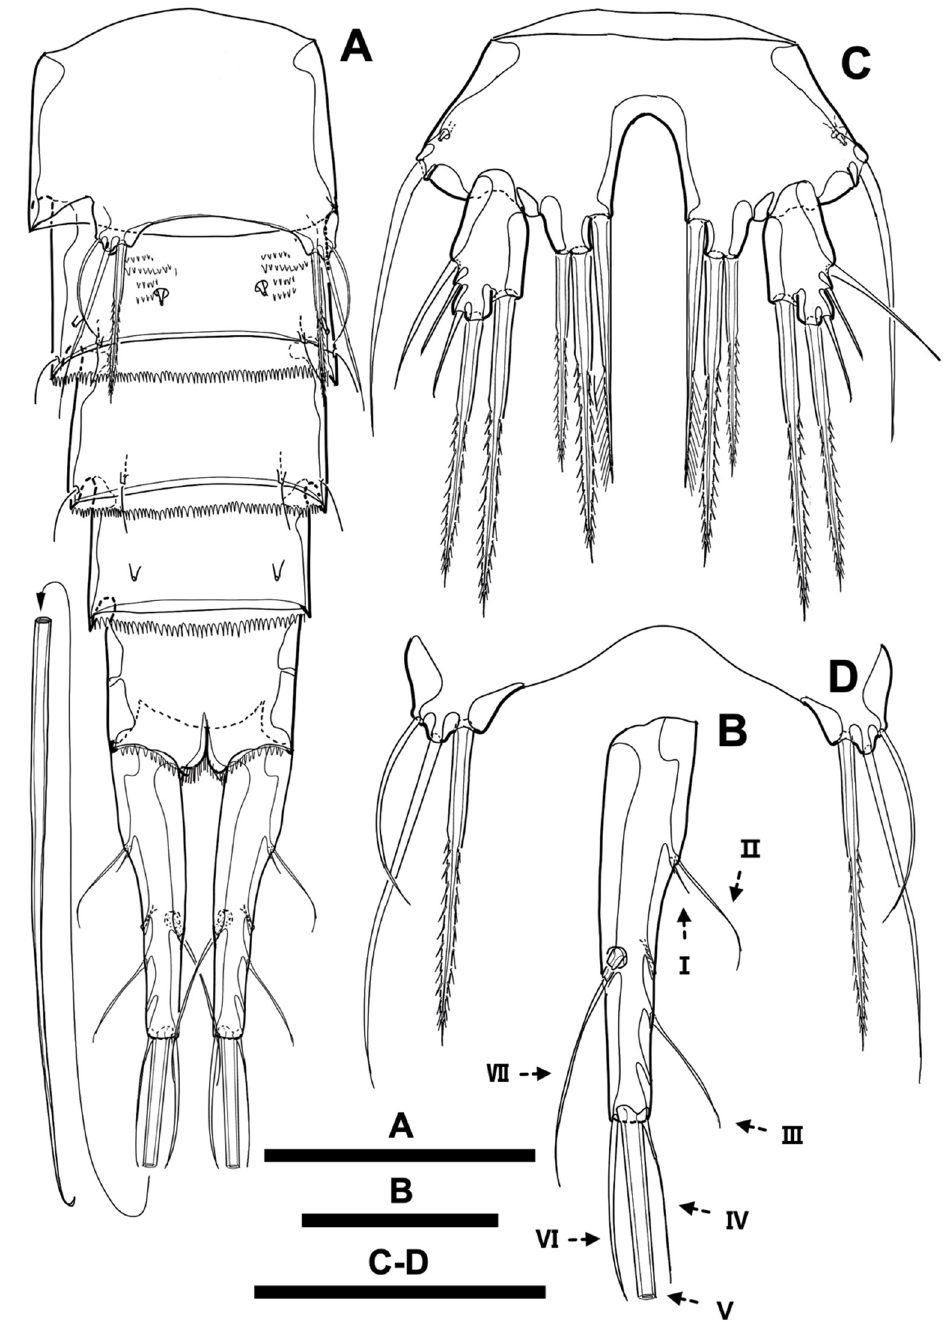
Figure 18. Line drawings of Phyllopodopsyllus saywakimi sp. nov. male (paratype 14): ( A ) urosome (excluding first urosomite); ( B ) caudal ramus; ( C ) P5; ( D ) P6. Scale bars: ( A ) 100 µm; ( B – D ) 50 µm. P5 (Figure 18C) not foliaceous and composed of baseoendopod and exopod; both rami fused at central part completely. Baseoendopod large, with cuticular pore near base of basal seta, and armed with three pinnate setae on endopodal lobe; basal seta as long as P5 and slender; median seta longest among endopodal armatures; innermost seta bipinnate terminally. Exopod about twice as long as greatest width, shorter than baseoendopod, and armed with five setae; two innermost setae bipinnate; other setae slender and bare.